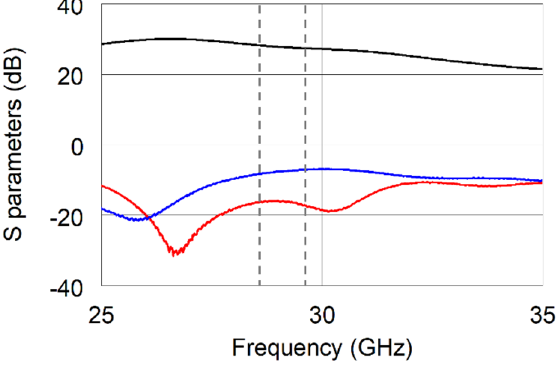
Figure 4. Measured S 21 (black solid line), S 11 (blue solid line), and S 22 (red solid line) of the APM-6702 amplifier.